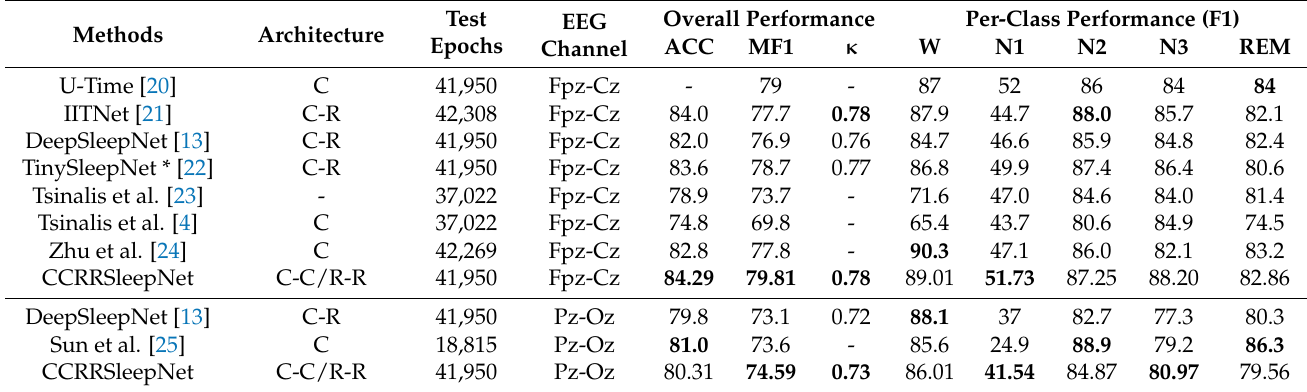
Bold denotes the best performance. C represents the CNN framework, C-R represents the frame or epoch level CNN sequence level RNN framework, and C-C/R-R represents CCRRSleepNet. The numbers in bold indicate the best performance indicators of all methods on the corresponding channel; * indicates reproducible